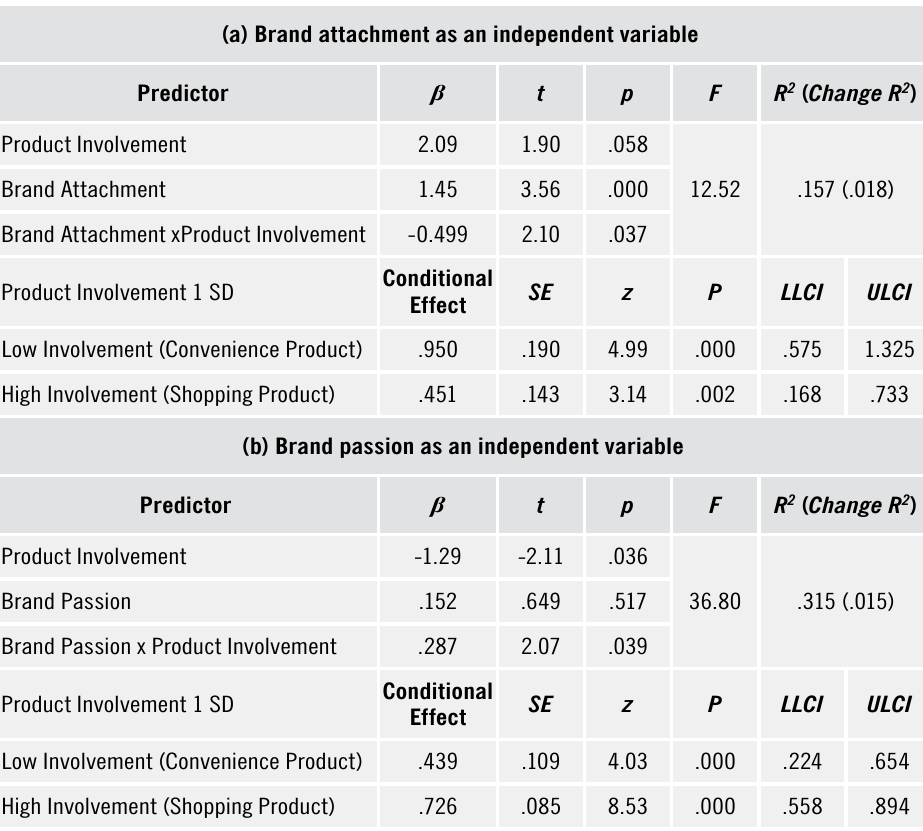
Table 6. Moderation effect of product